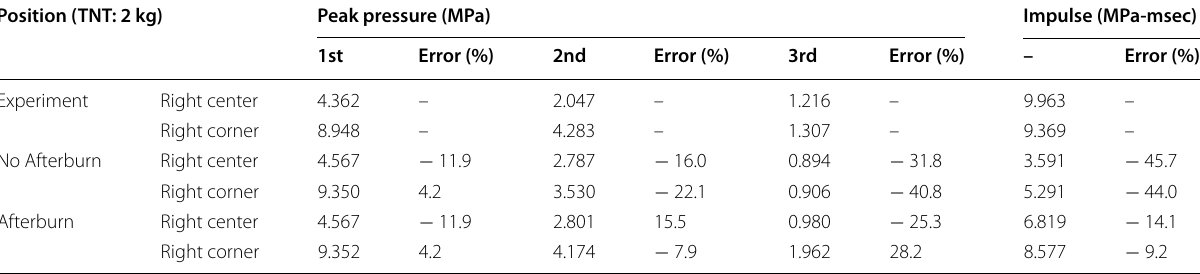
Table 3 Comparison of peak pressure and